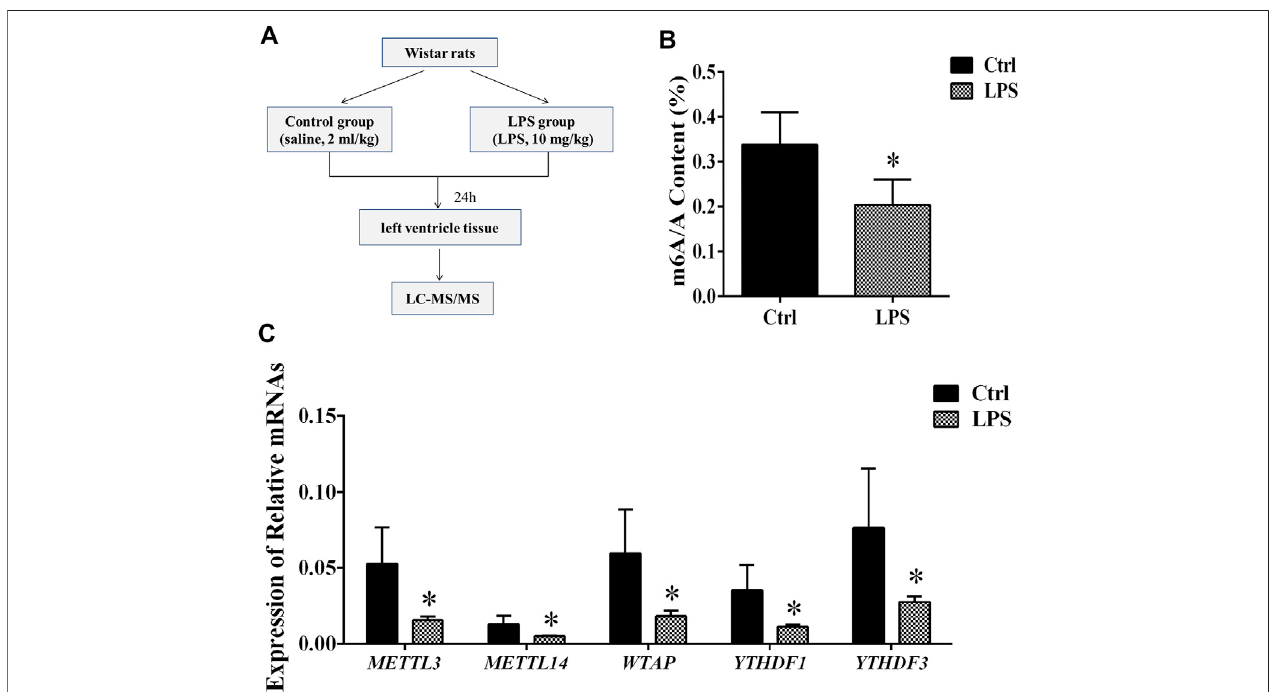
FIGURE 1 | Global level of m 6 A modi fi cation and mRNA levels of enzymes in left ventricle tissue. (A) Flowchart of tissue collection. (B) Global level of m 6 A modi fi cationmeasuredbyLC-MS/MSinleftventricletissue. (C) RelativeexpressionmRNAlevelsofm 6 A-relatedenzymesinleftventricletissueduringsepsis.ThemRNA levels were determined by qRT-PCR and normalized by GAPDH. * p < 0.05 versus the Ctrl group. Ctrl, control; LPS,